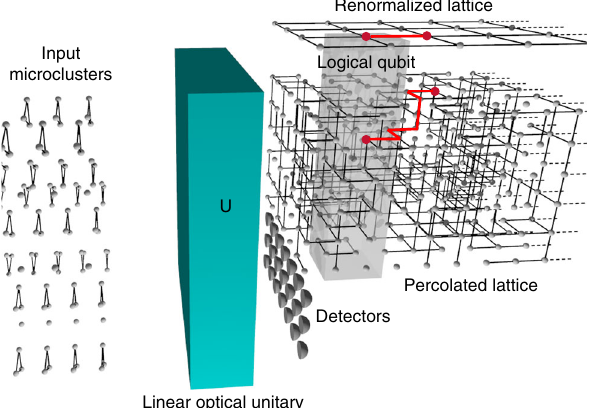
Fig. 3 Ballistic photonic cluster state generation for quantum computing. A steady stream of entangled clusters of n -photons or less ( n = 3 shown) is incident on a linear – optical interferometer (i.e., a multimode unitary transformation U ), which produces an entangled cluster of photons at its output. If the percolation condition is met, the output can be renormalized into a fully connected logical cluster for universal cluster-model quantum computing. The detector outputs are not used to herald whether or not the undetected outputs are in a universal cluster state. They always are. The detector outputs carry complete information on the location of missing edges in the random graph, and thus how to renormalize right with no loss of generality. Similarly, any photons or photon clusters used to boost any fusion gate are pushed to the left of U .